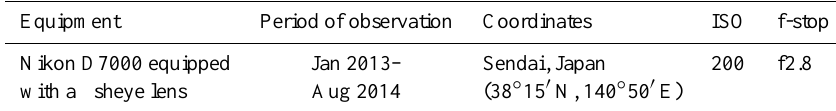
Table 1. Camera equipment characteristics.